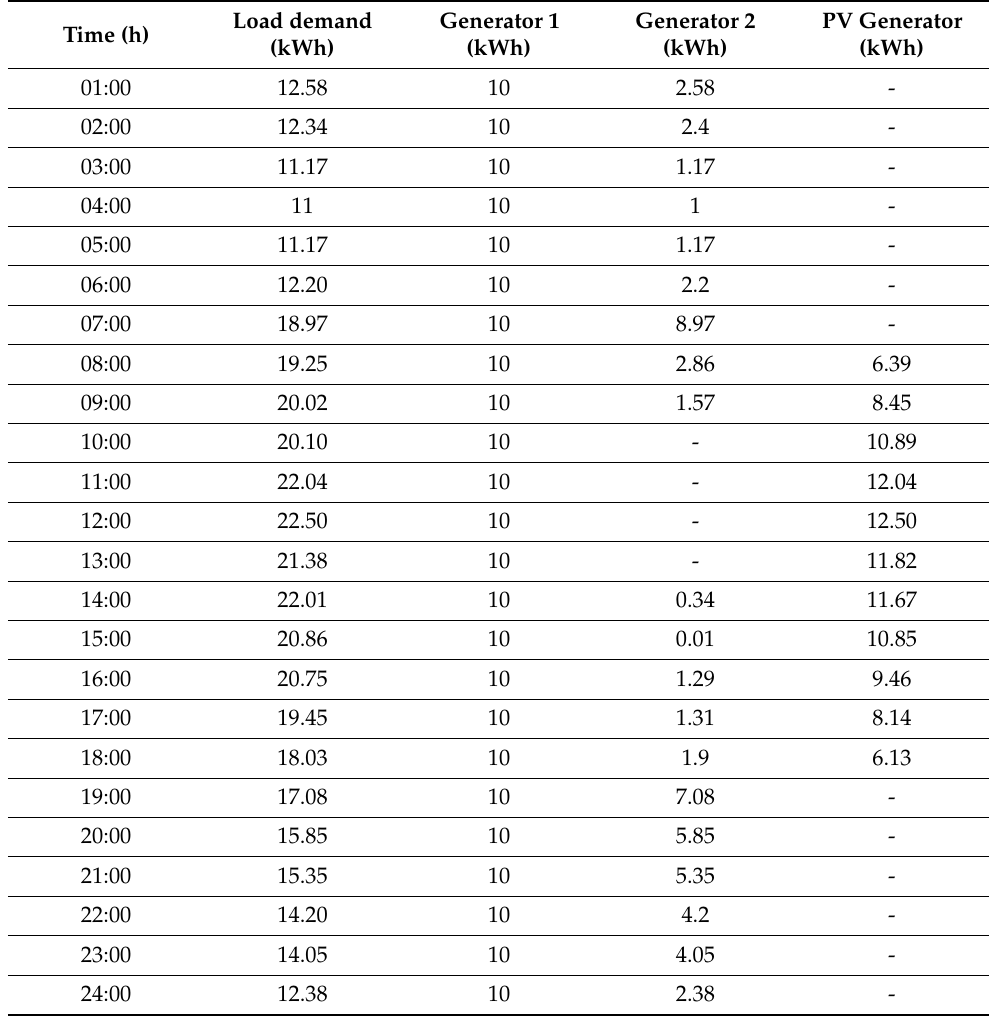
Table 6. Optimal power output for Case